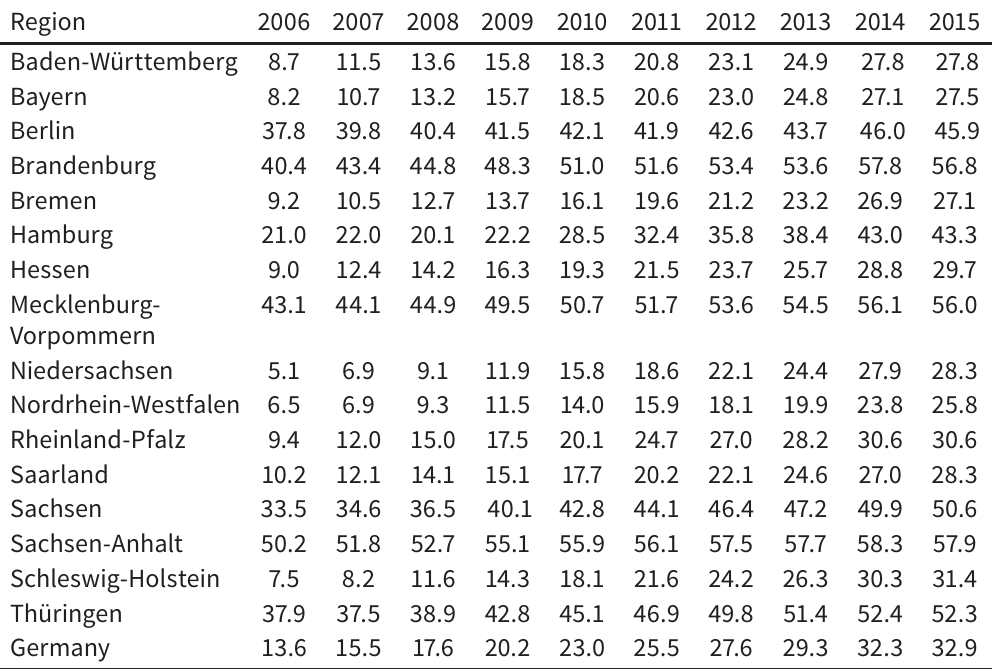
Public childcare enrollment rates for children younger than three